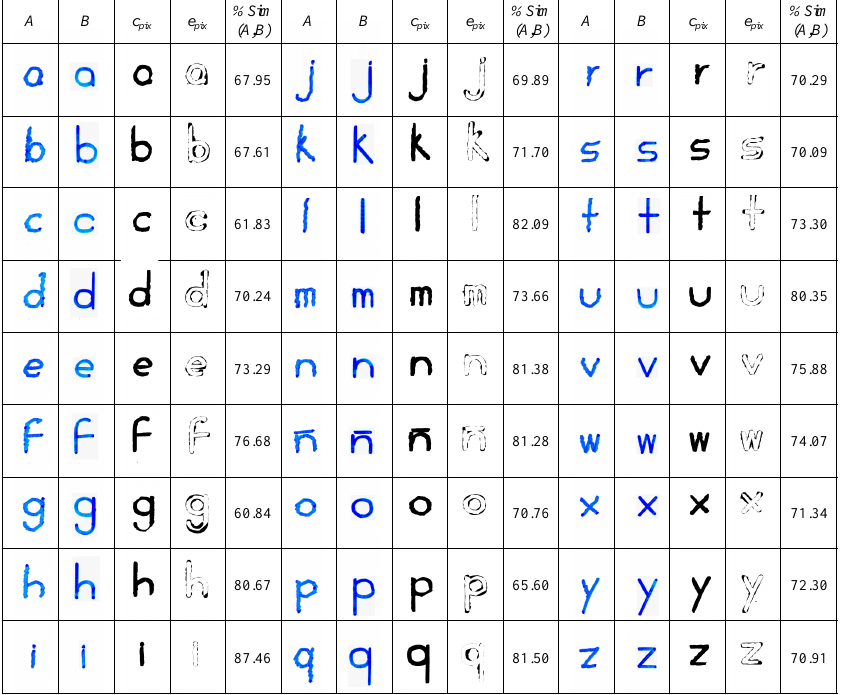
Figure 13. Results of the quantitative assessment of the alphabet characters presented in Figure